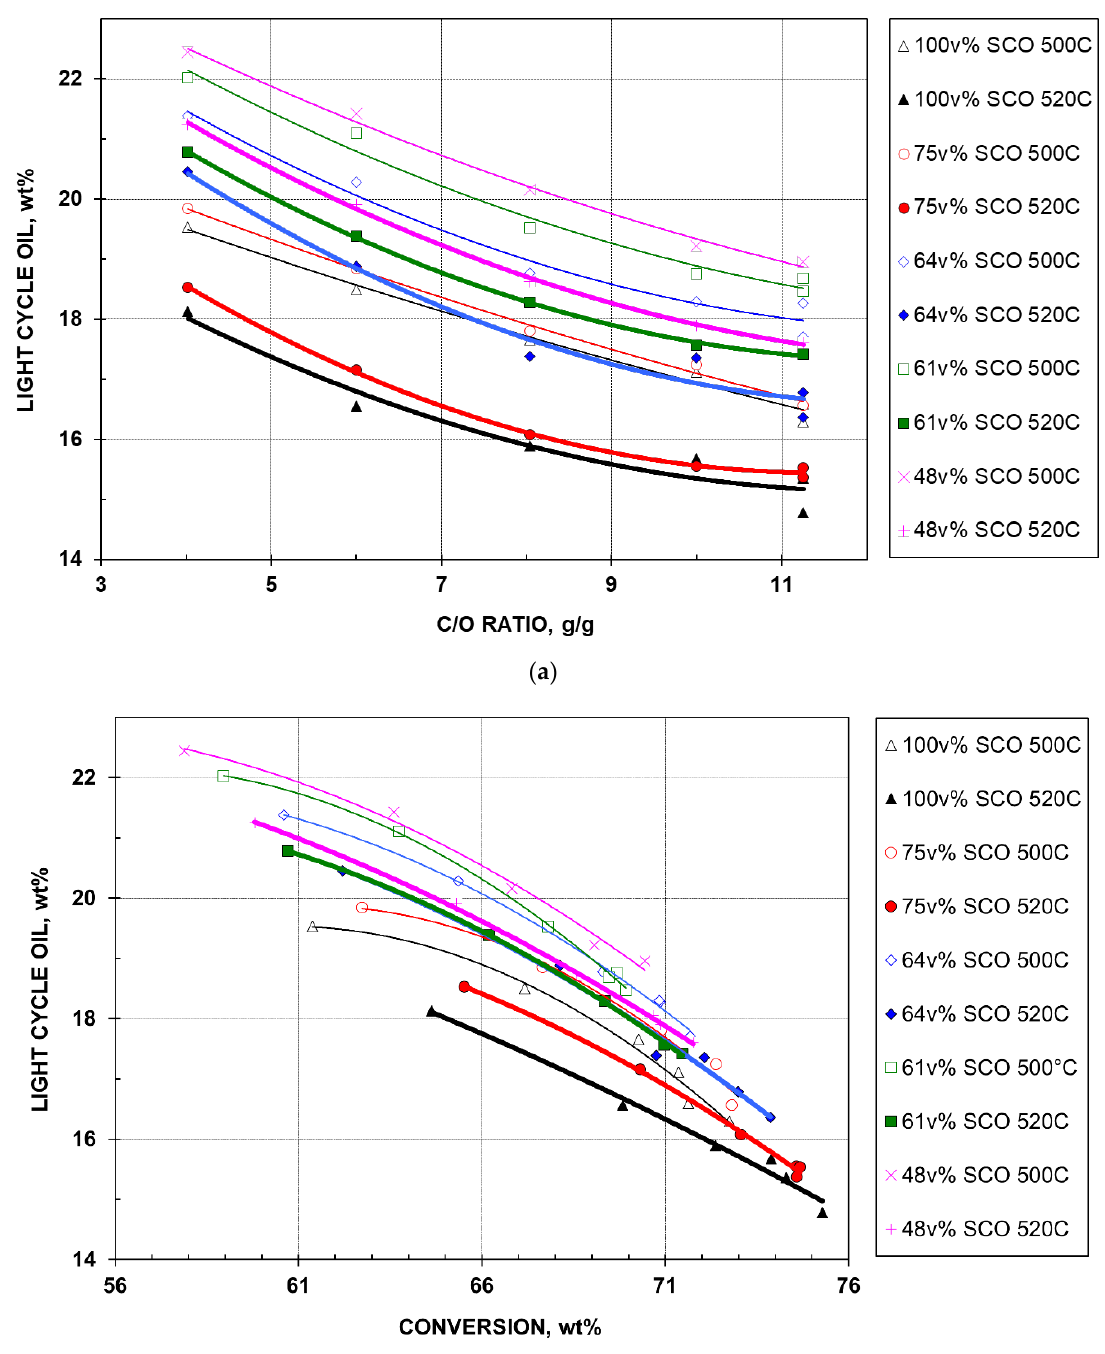
Figure 5. ( a ) LCO yield vs. C/O ratio at two reaction temperatures; ( b ) LCO yield vs. conversion at two reaction temperatures.